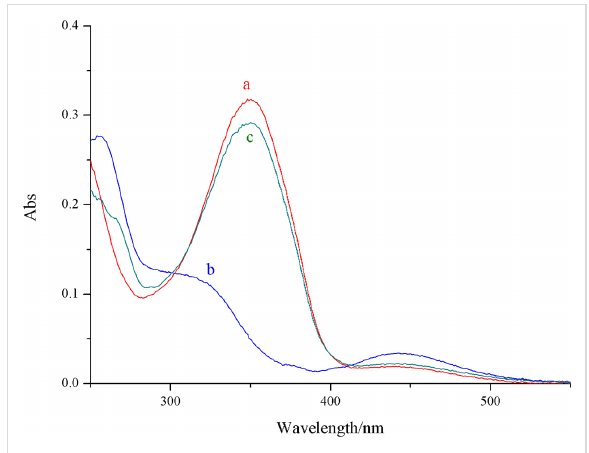
Figure 2: UV–vis absorbance spectra of a) compound 3 and b) irradiated by a light source of 365 nm and c) then treated by light of 420 nm. The concentration was 1.0 × 10 − 5 M in CHCl 3